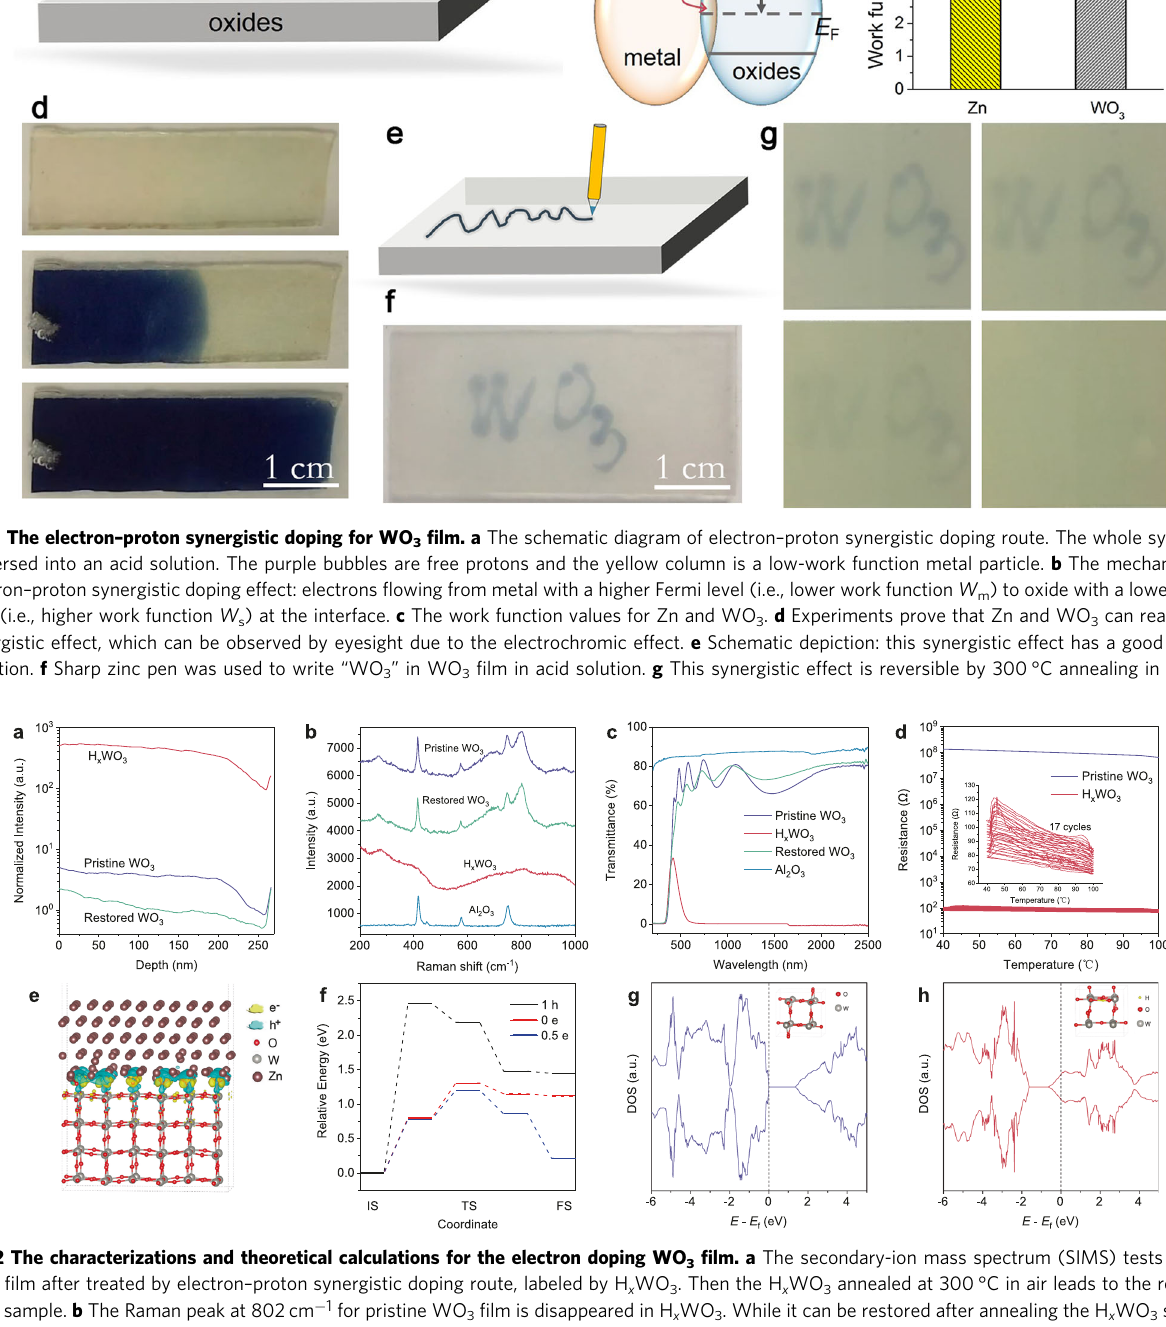
COMMUNICATIONS MATERIALS| (2021) 2:34 |https://doi.org/10.1038/s43246-021-00141-2|www.nature.com/commsmat